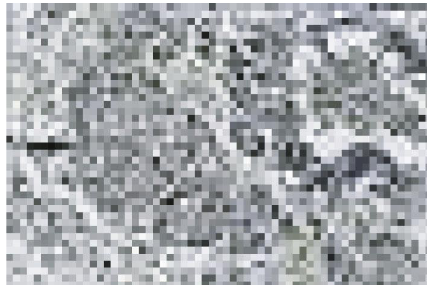
Figure 30: Vasospastic venous angiopathy. The black arrow points to a focus of adventitial muscle showing hydropic change akin to medial change in Figures 3 and 4. Movat stain × 200 (adapted with permission from the International Journal of Surgical Pathology 15(2) copyright 2007, Sage